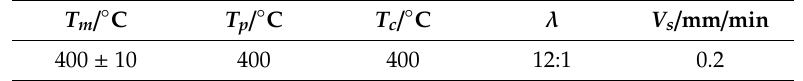
Table 2. Parameters of the indirect extrusion process ( T m , Mold temperature; T P , Preheat temperature; T c , Container temperature; λ , Extrusion ratio; and V S , Extrusion